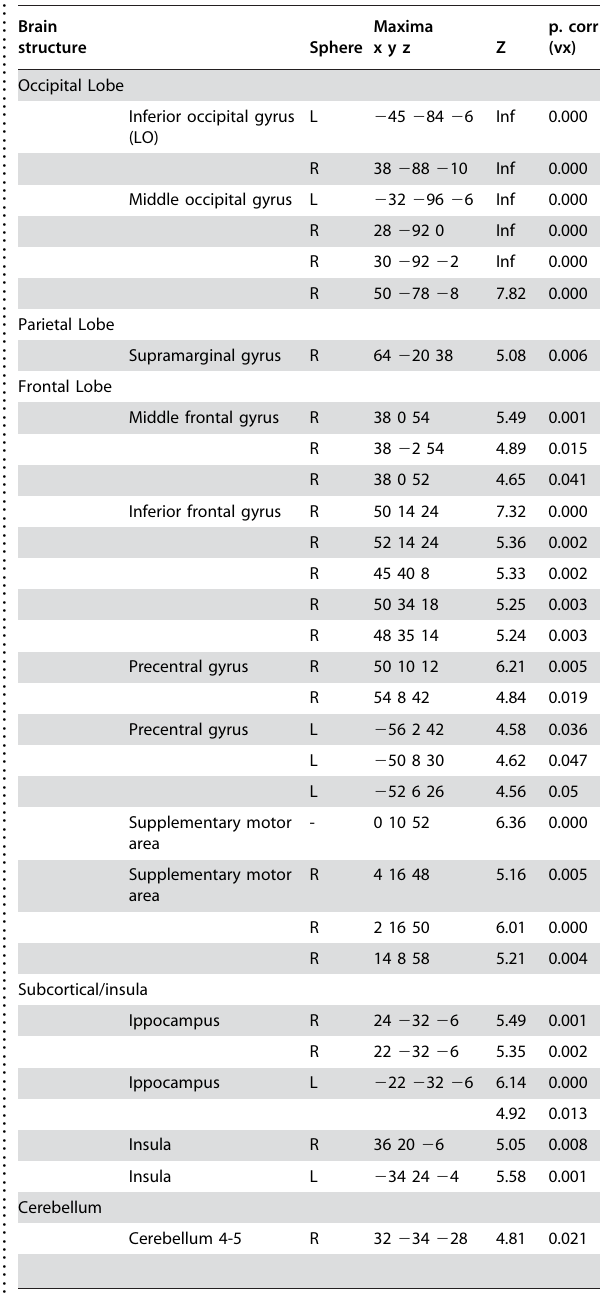
Table 1. Brain activity reflecting the common effects of Canonical and Modified images vs . baseline across conditions